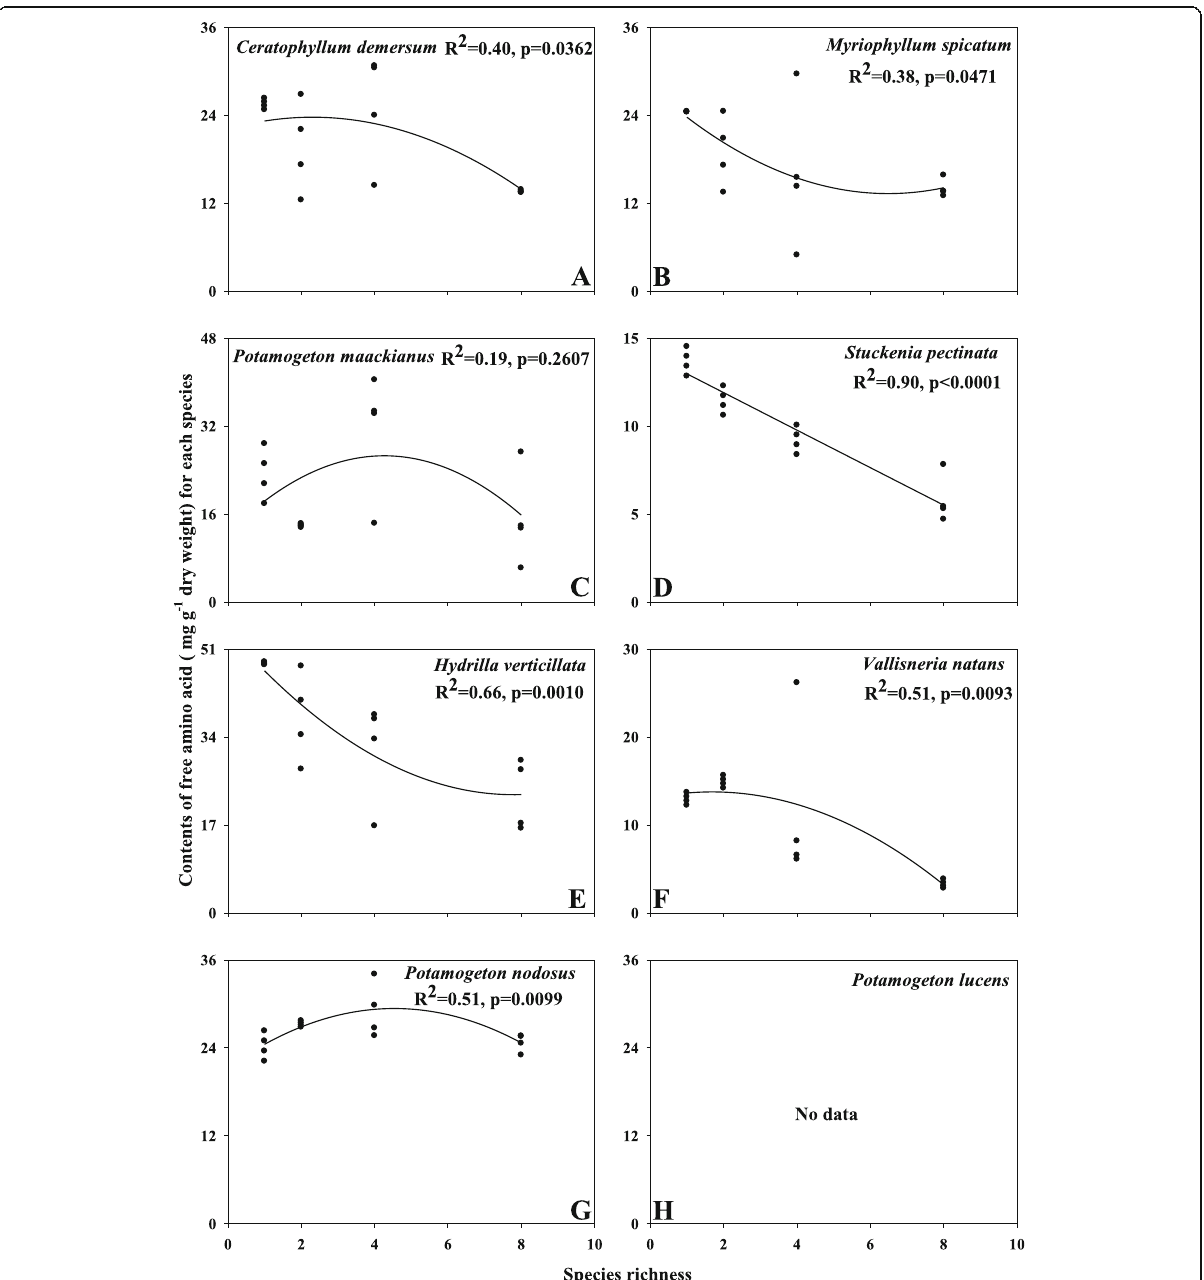
Fig. 4 The plant free amino acid of individual species along an aquatic plant biodiversity gradient in Lake